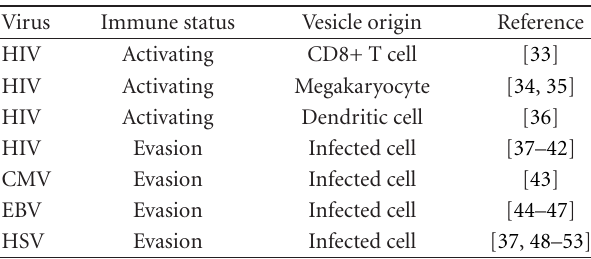
Table 1: Selective overview of viruses and vesicle